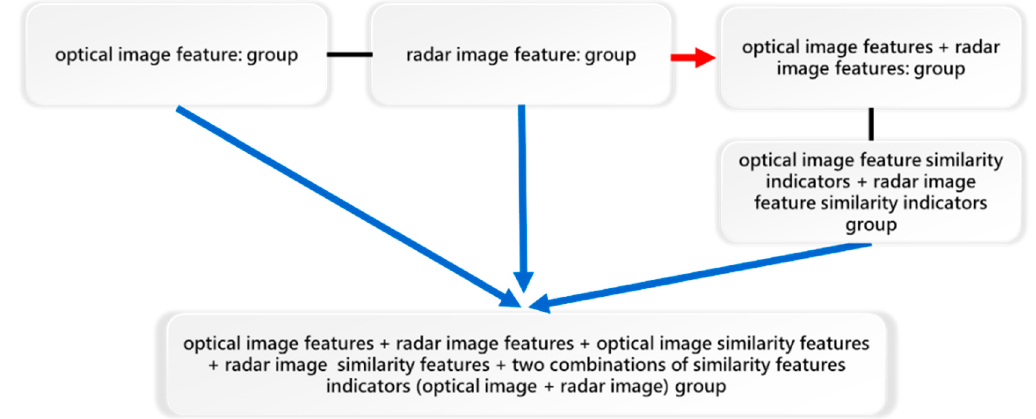
Figure 5. The DTW index of analyzed data sets for